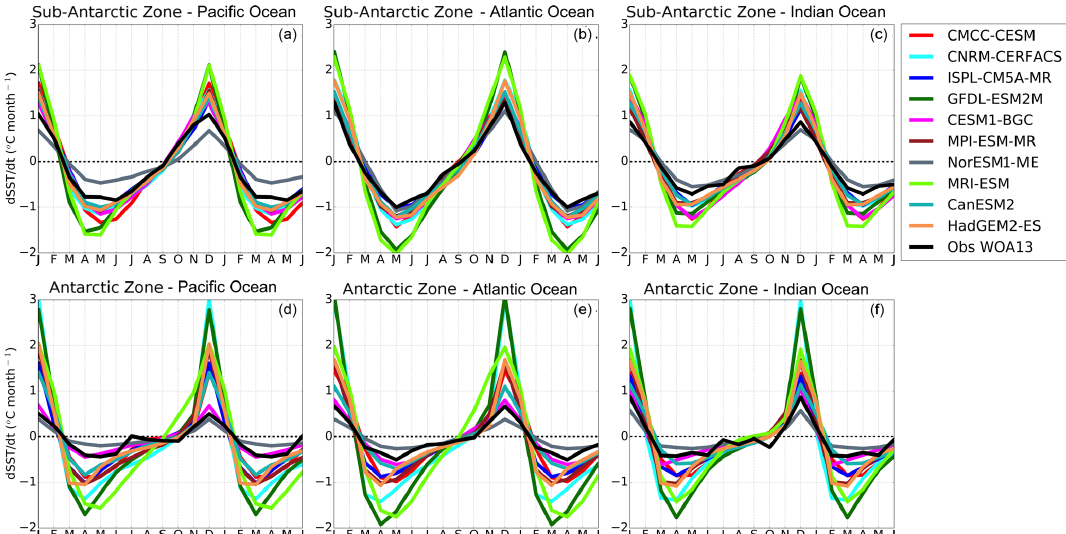
Figure 5. Mean seasonal cycle of the estimated rate of change of sea-surface temperature (dSST / d t , ◦ Cmonth − 1 ) for the Sub-Antarctic and Antarctic zones of the Pacific Ocean (first column), Atlantic Ocean (second column) and Indian Ocean (third column).